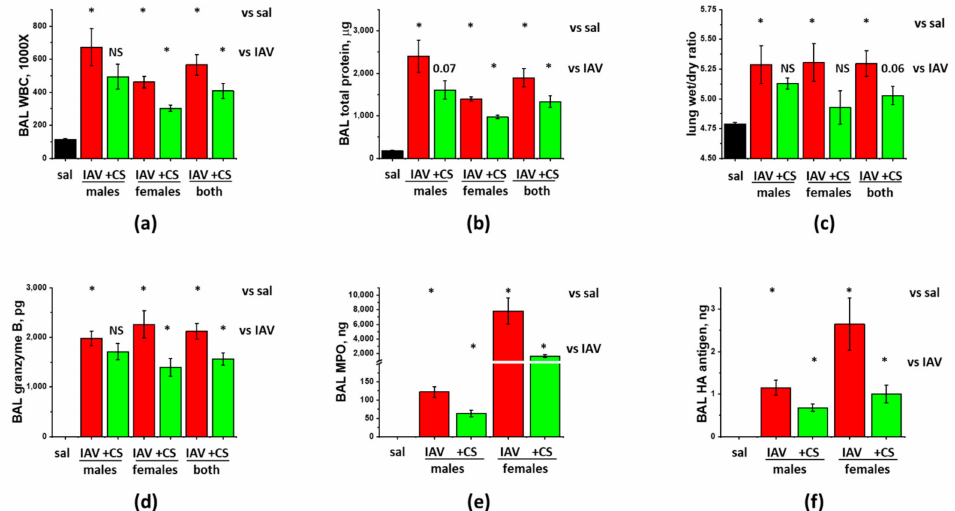
Figure 3. ASC-CS administration limits BAL protein and inflammatory cell extravasation, and increases in granzyme B and MPO without compromise of viral clearance in IAV-infected mice. C57Bl/6 mice received intranasal administration of IAV H1N1 PR8 (800 pfu/mouse) on Day0. Mice receiving vehicle control for IAV are annotated as saline (sal, black columns). On Day6 and 8, IAV mice were sub-cutaneously injected with 2.25 mg/kg of ASC-CS (CS, green columns) or an equivalent volume of PBS (red columns designated as IAV). Lungs and BAL were collected on Day9 to analyze for BAL white blood cell count ( a ) and total protein levels ( b ), lung wet/dry ratio ( c ), acellular BAL granzyme B ( d ) and MPO ( e ) levels, and PR8 hemagglutinin (HA) level ( f ). n = 4–6 per group, presented are mean +/ − SEM. * for p < 0.05 by t -test with Welch correction (unequal variances) between (1) IAV groups and the control group (vs. sal), and (2) CM groups and the corresponding gender IAV group (vs. IAV).